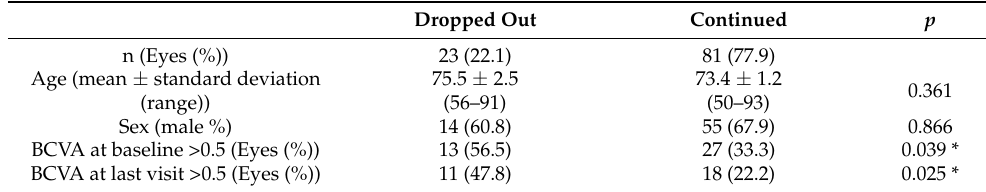
Table 3. Characteristics of the patients who dropped out before month